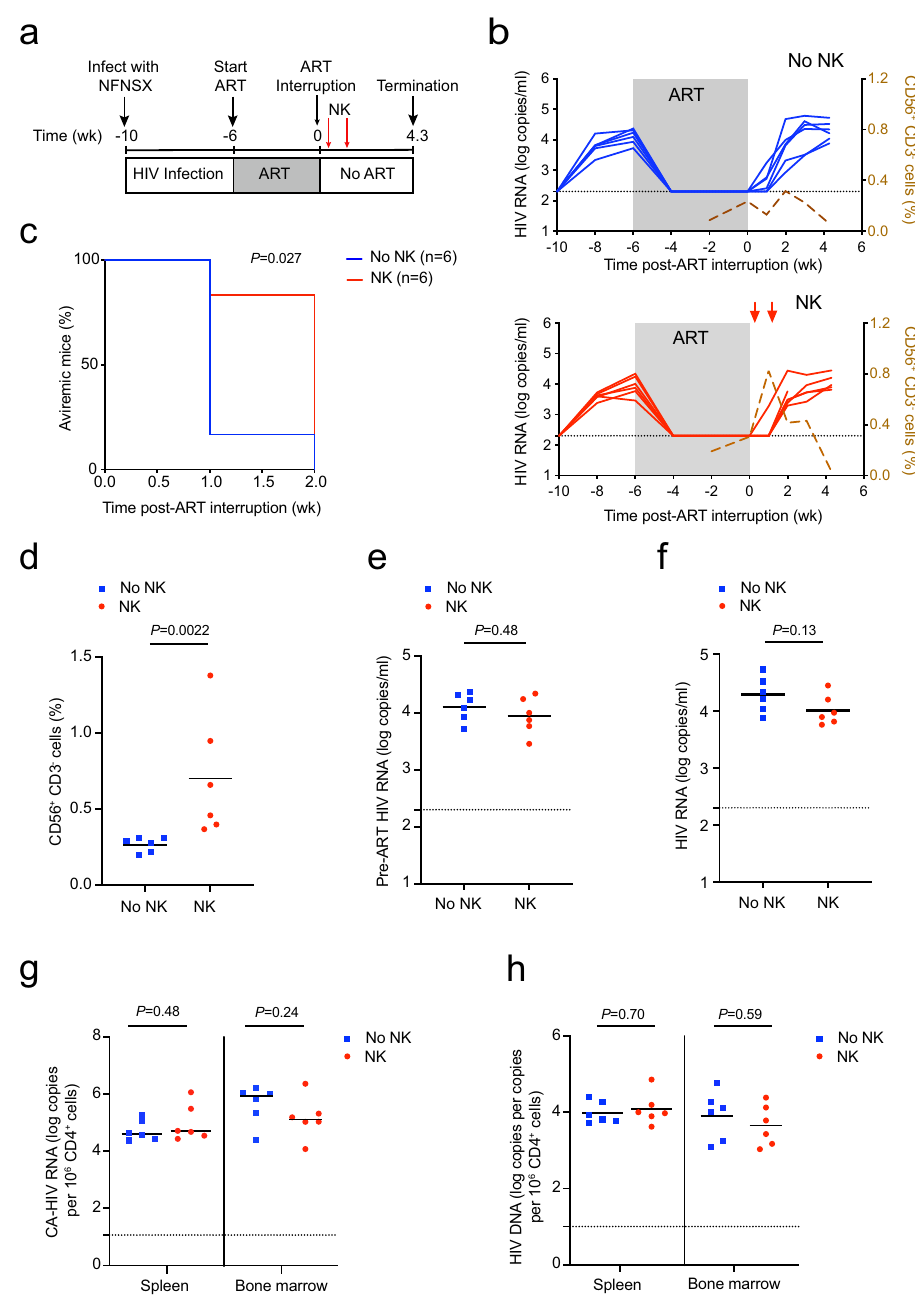
Fig. 1 NK cells delay time to viral rebound after ART interruption in BLT mice infected with HIV strain NFNSX. a Schematic representation of experiment; acute infection of TKO-BLT mice with NFNSX for 4 weeks, ART for 6 weeks. One day after ART interruption, 5 × 10 6 allogeneic human peripheral blood NK cells were transferred followed by another homologous dose of NK cells 5 days later. The red arrows denote when NK cells were given. b Longitudinal plasma viral loads for each infected animal at various timepoints in the No NK (blue) and NK (red) groups. Gray shading indicates an ART treatment period of 6 weeks. A dashed brown line indicates the median frequency of CD56 + CD3 − cells detected in the blood. c Kaplan – Meier curves showing the frequency of aviremic mice after ART interruption. P value calculated by log-rank Mantel – Cox test. d Frequency of CD56 + CD3 − cells in the blood 5 days after the fi rst injection of NK cells. e , f Plasma viral loads for each animal before ART was initiated ( e ) and at necropsy ( f ). g , h Cell-associated “ CA ” HIV RNA ( g ) and HIV DNA ( h ) levels from the spleen and bone marrow of each infected animal. n = 6 biologically independent animals in each group observed over one independent experiment ( b – h ). The Black dotted line indicates the detection limit of 2.3 log RNA copies per ml ( b , e , f ) and 1.0 log RNA or DNA copies ( g , h ). Horizontal bars represent the means ( d – h ). P values were calculated using a two-tailed Mann – Whitney test ( d – h ). Source data are provided as a Source Data fi